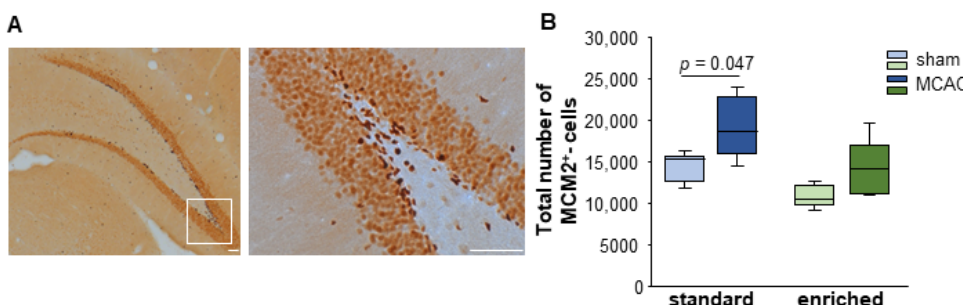
Figure 3. Proliferation of MCM2 + cells after stroke and EE housing. ( A ) Peroxidase-stained images of MCM2 + cells in the dentate gyrus. Dark brownish cells were identified as MCM2 + cells. ( B ) Significant changes in the endogenous proliferation in the dentate gyrus were detected under standard housing conditions. Statistical analysis was performed using the Mann–Whitney U test, scale bar = 100 µm, higher magnification 10 µm.